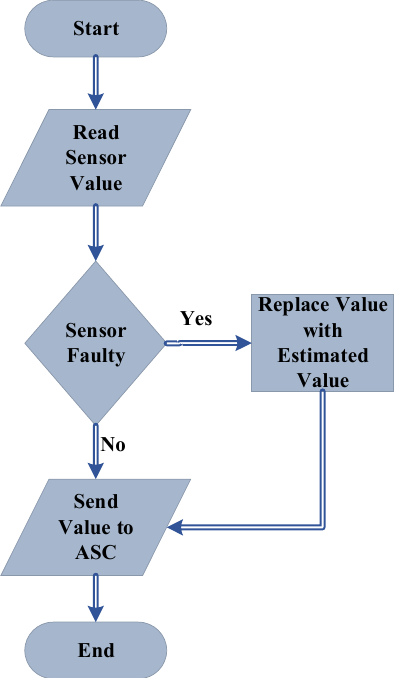
Figure 10. The fault-tolerant anti-surge control flowchart. Table 1. A comparison of the CC HYSYS model with practical